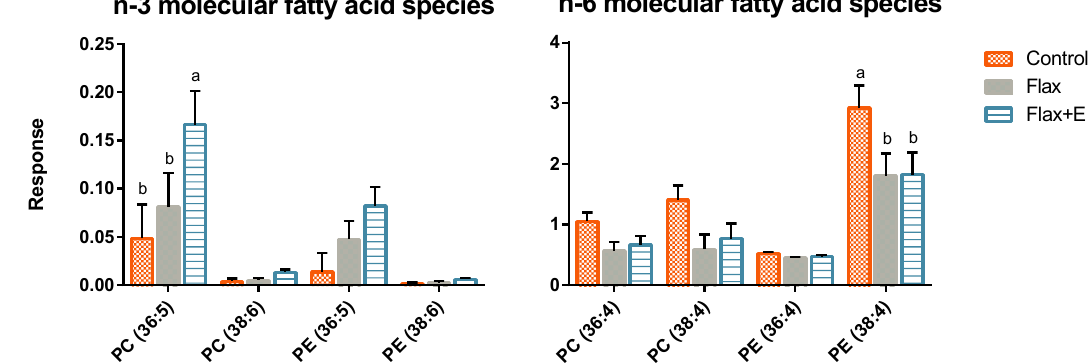
Figure 2. Effect of flaxseed and enzyme supplementation on liver phospholipid molecular fatty acid species. Control, Flax, Flax+E represent corn-soybean meal basal diet (Control), and basal diet with 10% whole flaxseed (Flax) plus 0.05% enzyme (Flax+E). The a–c means with no common superscript within a cluster differ when p < 0.05. n = 8. Peak intensities were used for relative quantification of fatty acid species in liver tissue.